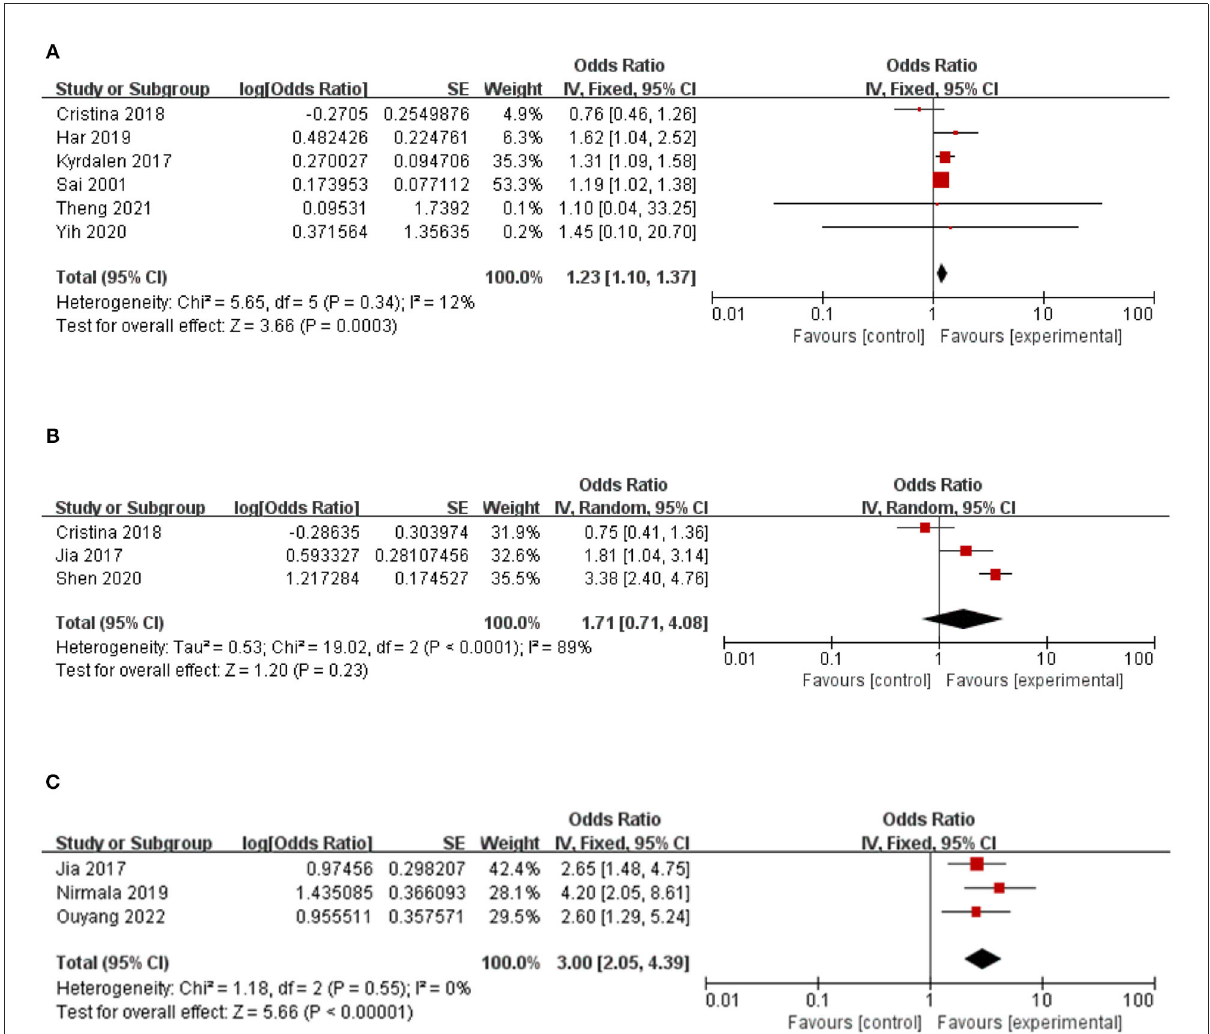
FIGURE4 A forest plot for the association between falls among community-dwelling older adults. (A) Depression. (B) Osteoporosis. (C) Balance disorder.